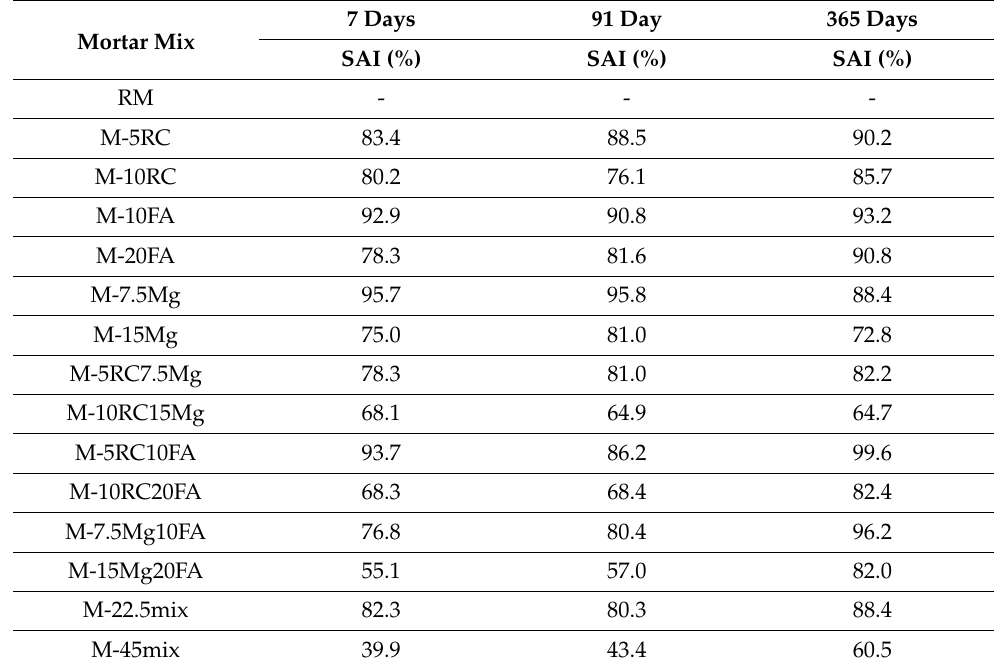
Table 6. Strength activity index between 7 and 365 days of